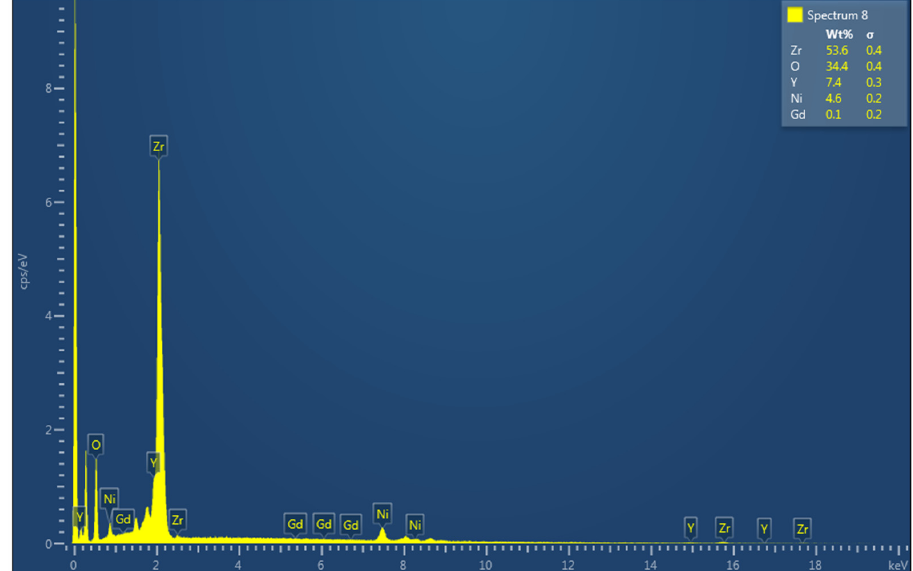
Figure 10. The EDX spectrum of the fresh 5Ni+4Gd/YZr catalyst.